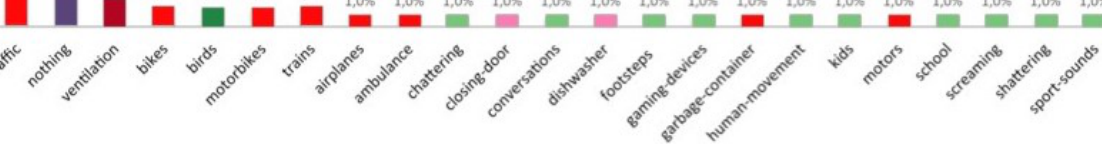
Figure 6: Diagram showing the sounds disturbing the app users’ sense of quietness in the “everyday quiet areas” © A. Radicchi 2018